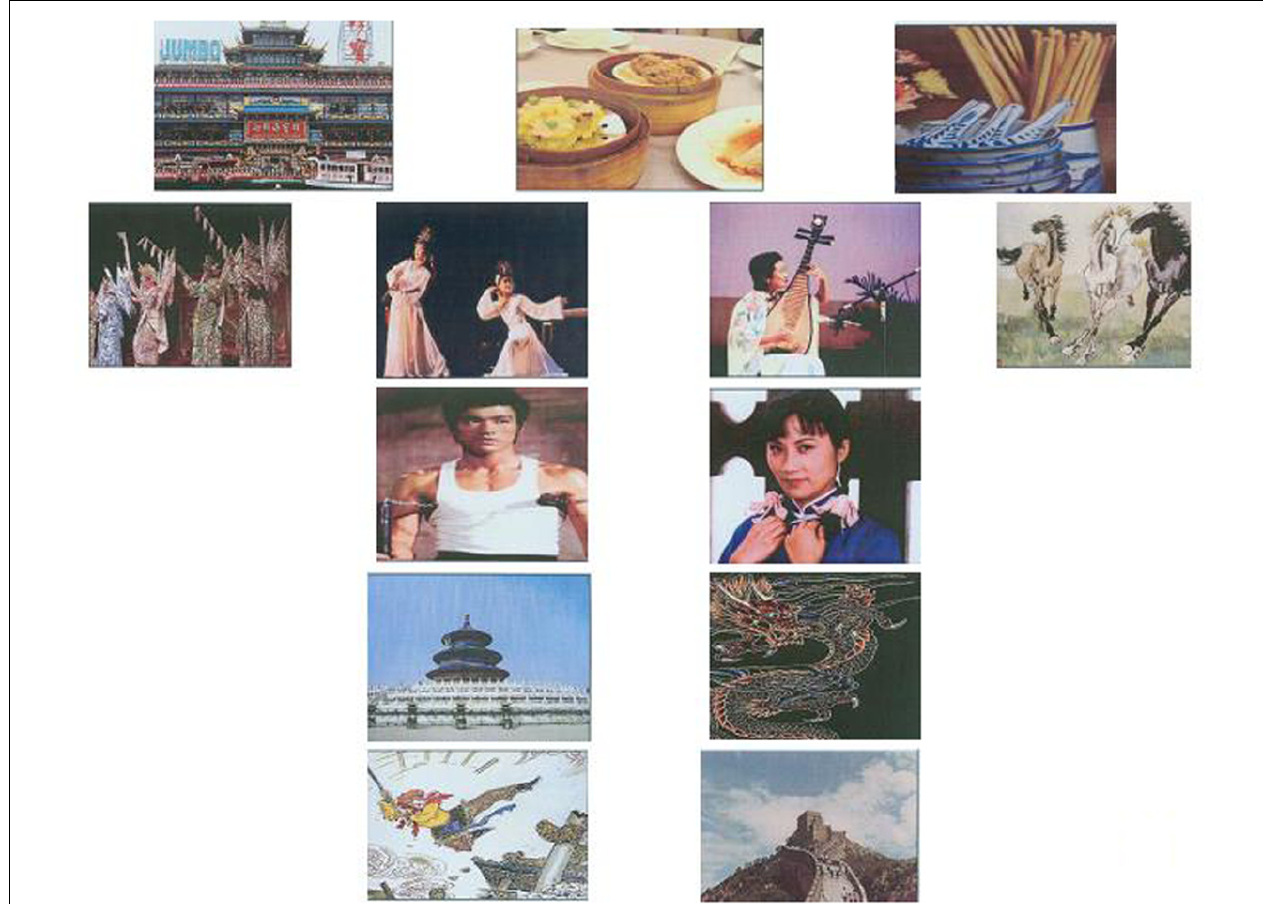
FIGURE 1 | Chinese